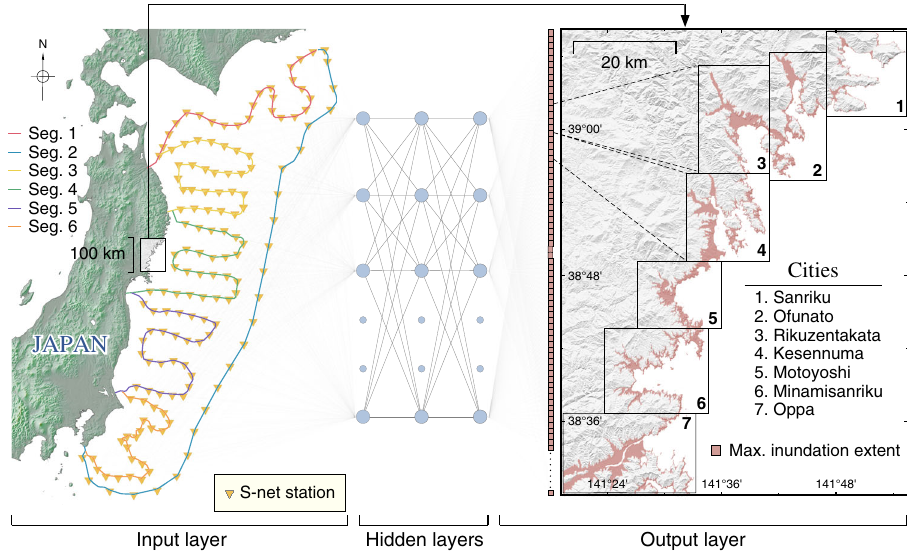
Fig.1|Theschematicoftheproposedmethod. Locationsofinterestareshownwithmaximuminundationextentonthetrainingset.S-netstationsegmentsaremarked with colored lines.